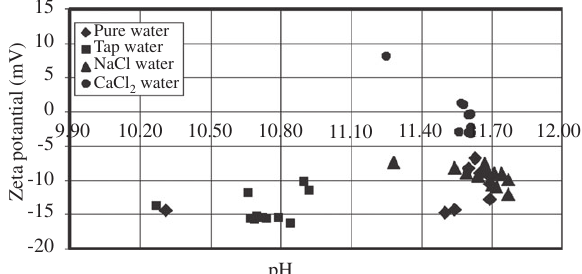
Figure 7 Zeta potential of cement particles in various types of water vs.